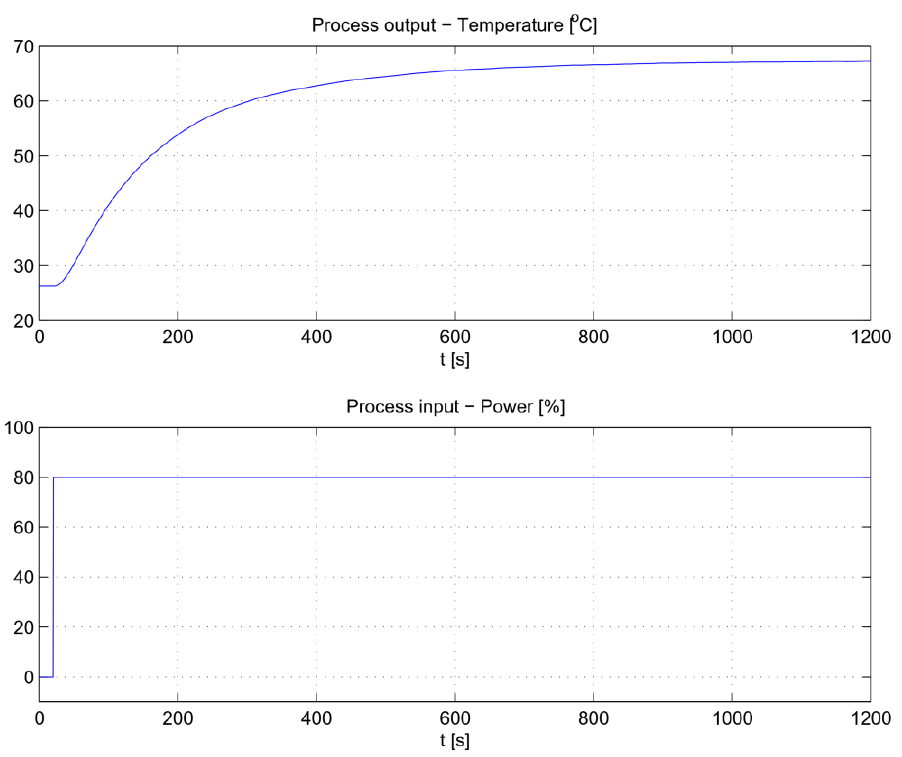
Figure 24. The thermal process open-loop response.